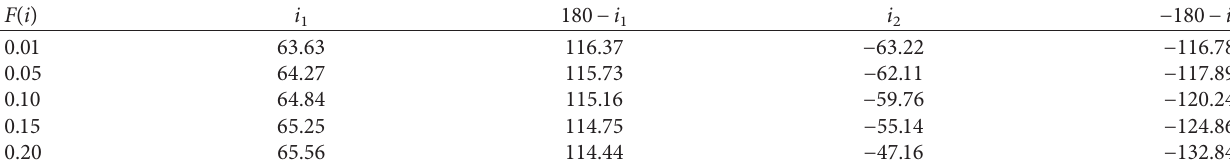
Table 1: Real values of i (in degree) corresponding to the given values of F ( i ).